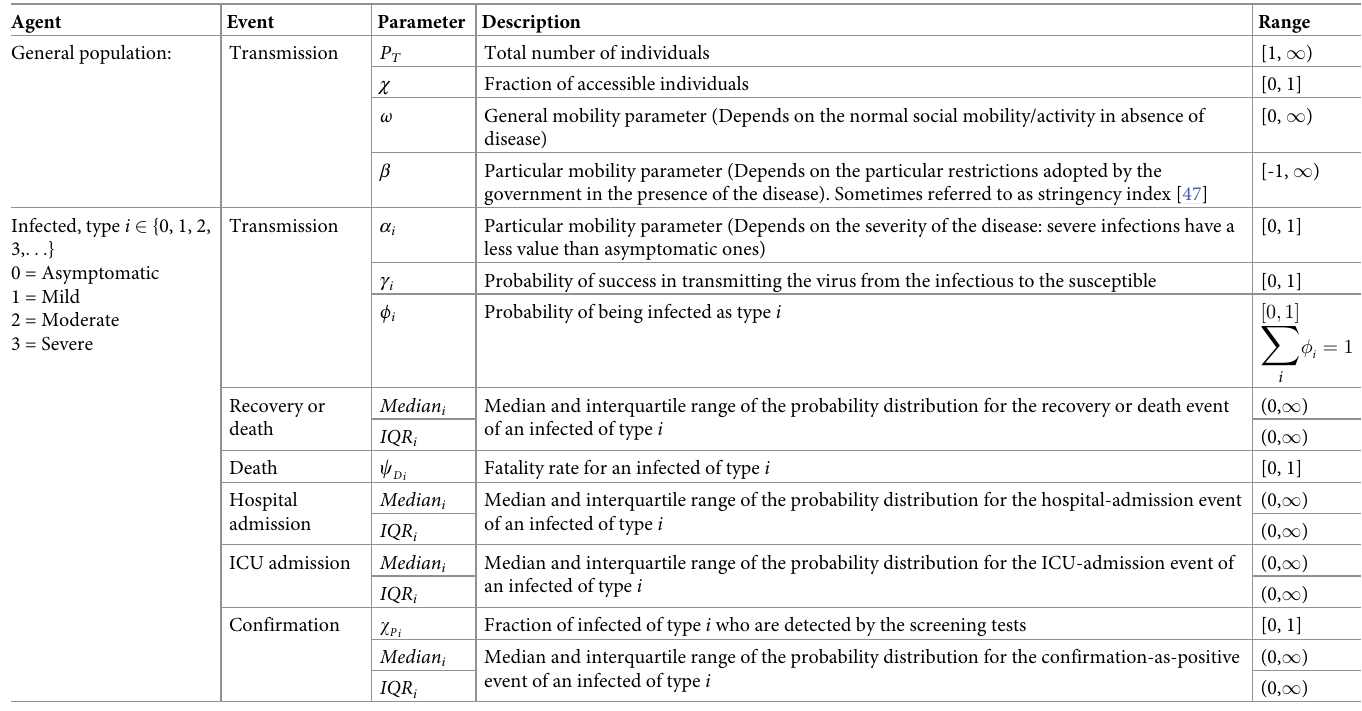
Table 1. List of parameters used in the proposed model. Additional details are in S1 Text. Agent